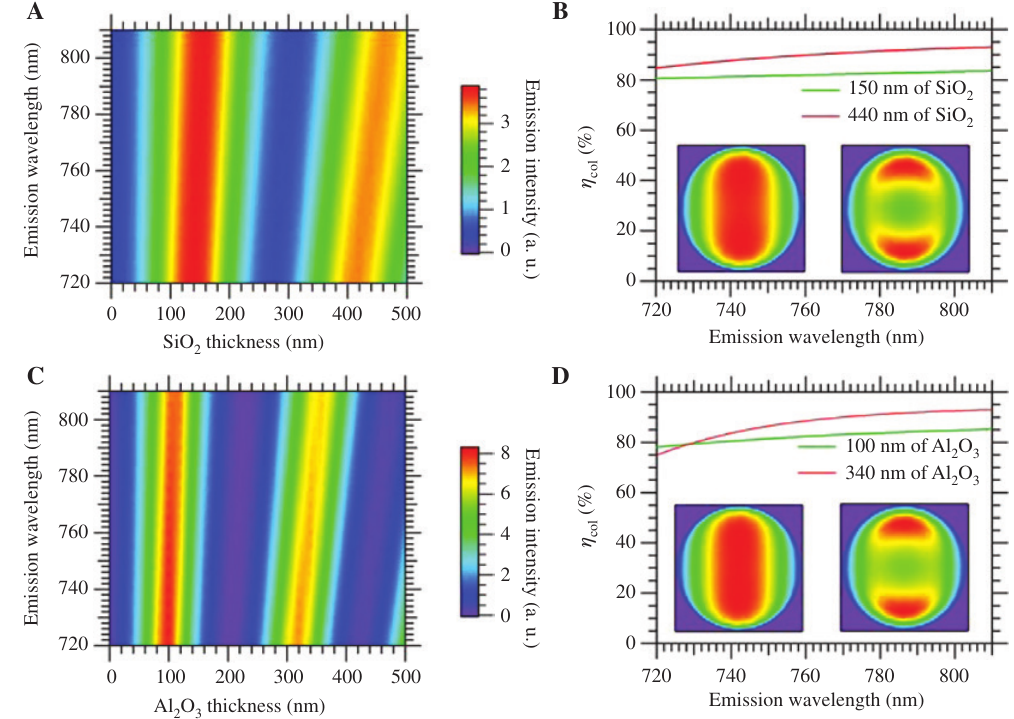
deposited on a SiO /Si substrate as a function of the emission wave- Figure 6: (A) Calculated single-photon emission intensity in SL WSe 2 2 length and the SiO thickness. (B) Calculated single-photon collection efficiency for SiO thicknesses of 150 and 440 nm. The insets show 2 2 the far-field emission patterns of SPEs radiating at 760 nm for both 150 (left) and 440 nm (right) SiO thicknesses. (C) Calculated single- 2 photon emission intensity in SL WSe deposited on Al O /Al substrate as a function of the emission wavelength and the Al O thickness. (D) 2 2 3 2 3 The insets show the far-field emission patterns of SPEs radiating at 760 nm for both 100 (left) and 340 nm (right) Al O 2 3